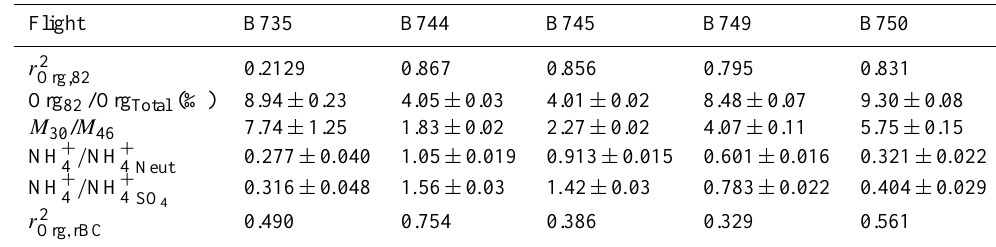
Table 2. Diagnostic ratios for the five flights. All ratios are slopes from linear regressions (with intercepts fixed at 0) with associated uncertainties, except Org 82 /Org Total , which is a ratio of means with associated standard error, for the sake of comparability with Robinson et al. (2011), although due to the high degree of correlation, slopes from linear regressions were numerically very similar. With M 30 / M 46 , M 46 was treated as the dependent variable due to its lower